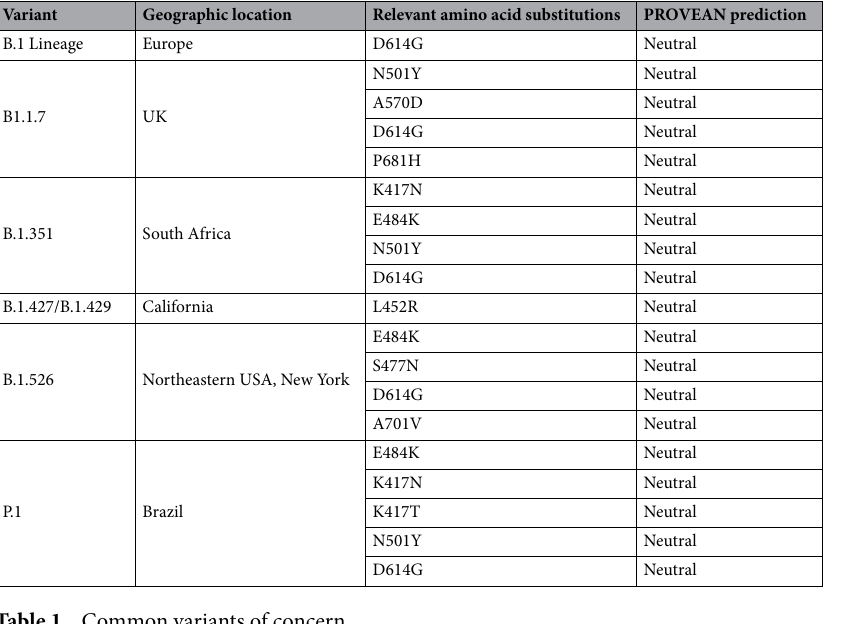
Table 1. Common variants of